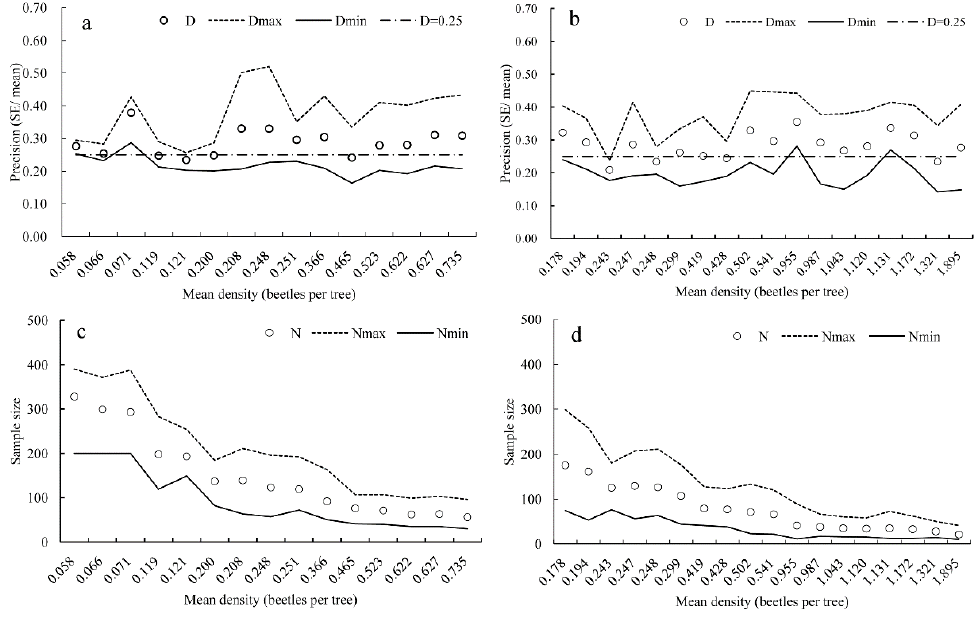
Figure 4. Resampling analyses of Green’s sequential sampling plan using independent field data for Tomicus minor ( a , c ) and Tomicus yunnanensis ( b , d ). The dash horizontal lines in ( a , b ) represent the desired level of precision